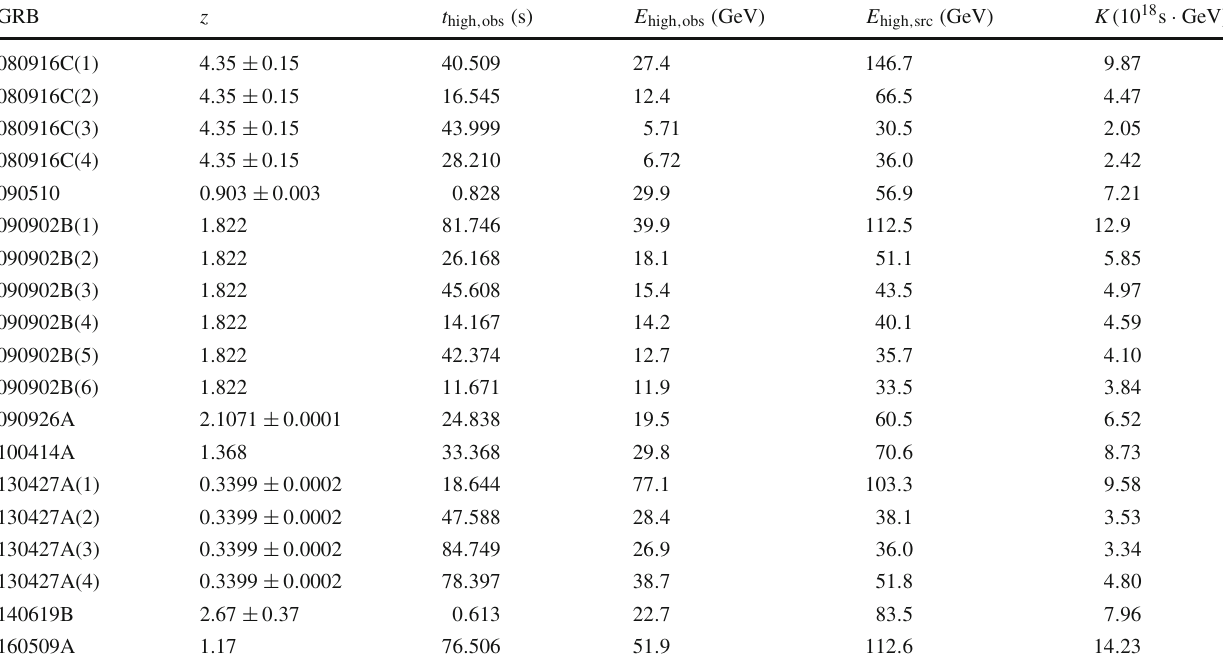
Table 1 The data of high energy ( > 30 GeV) photon events from GRBs with known redshifts, read from Pass-8 data [22] of the FERMI telescope. t high , obs refers to the observed arrival time since trigger